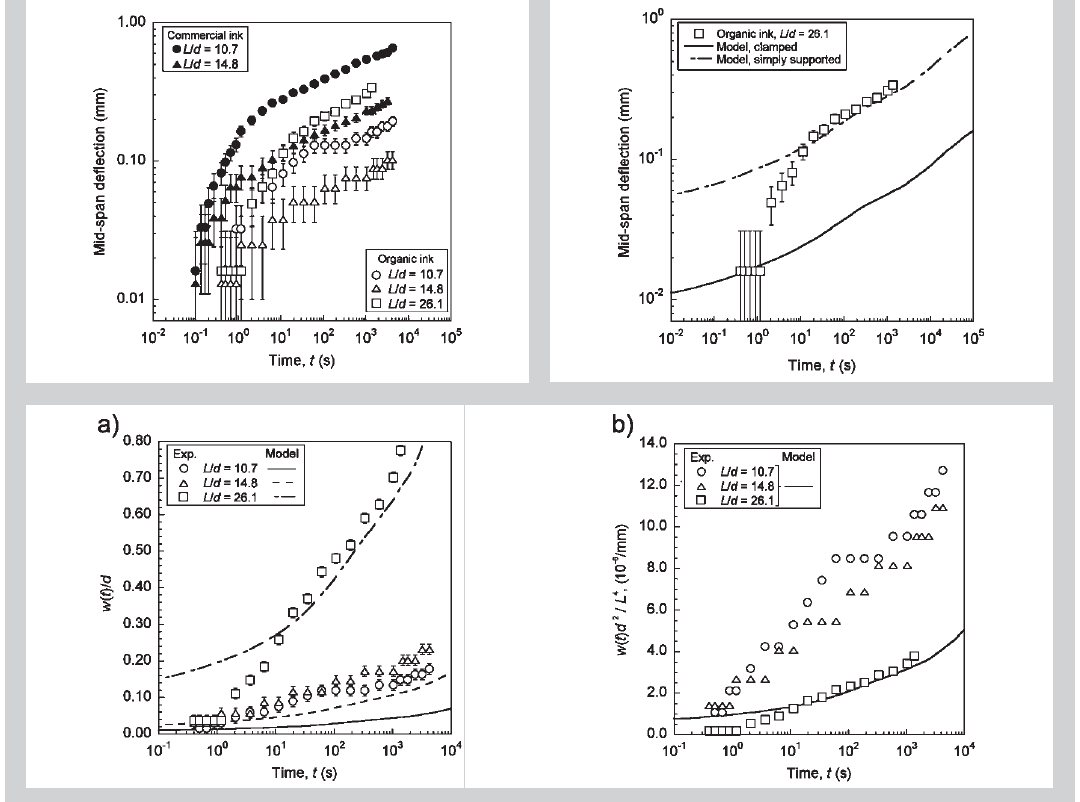
Figure 9 (left above): Self-supporting ink filament experimental results for organic and commercial inks at T = 20 ∞ C. Figure 10 (right above): Experimental data and structural model predictions using clamped and simply supported boundary condi- tions for organic ink (L/d = 26.1), T = 20 ∞ C. Figure 11 (below): Normalized mid-span deflection of organic ink self-supporting filament and structural model predic- tions using simply support- ed boundary conditions, T = 20 ∞